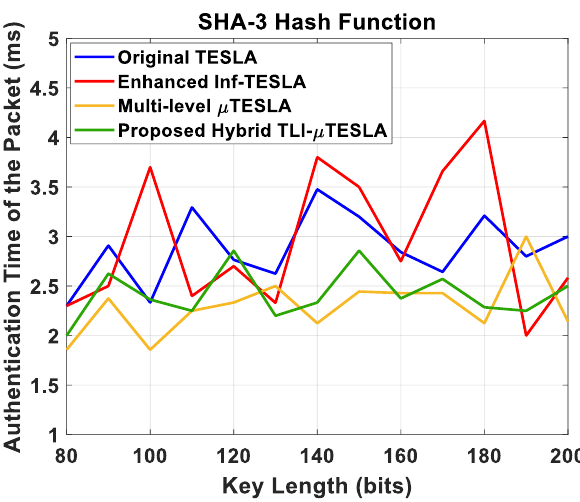
Figure 14. Simulation results of the original TESLA protocol (blue line), enhanced Inf-TESLA protocol (red line), Multilevel- µ TESLA protocol (yellow line), and Proposed Hybrid TLI- µ TESLA protocol (green line), demonstrating the authentication time of the low-level (message) packets with the change in the key size using SHA-3 Hash Function.